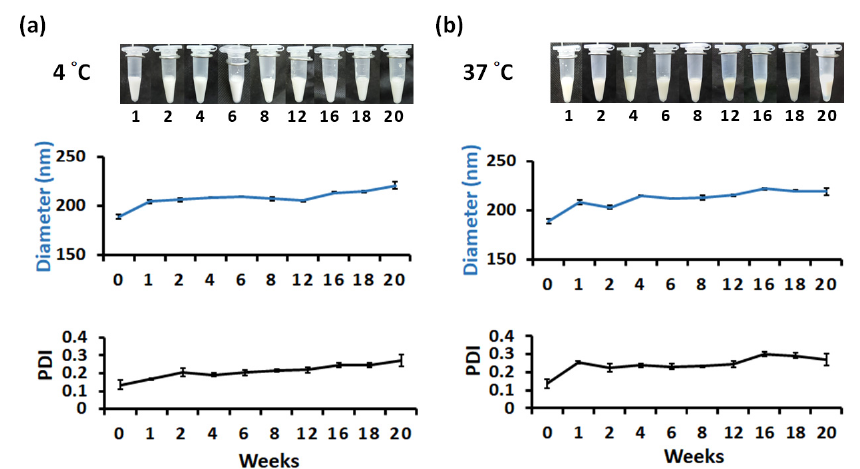
Figure 3. The changes of visual appearances, particle size and polydispersity index (PDI) of SQ@HACH upon storage at ( a ) 4 °C for 20 weeks and ( b ) 37 °C for 20 weeks. The diameter and PDI of SQ@HACH (100-fold dilution) were measured by DLS. (n = 3, mean ± SD).